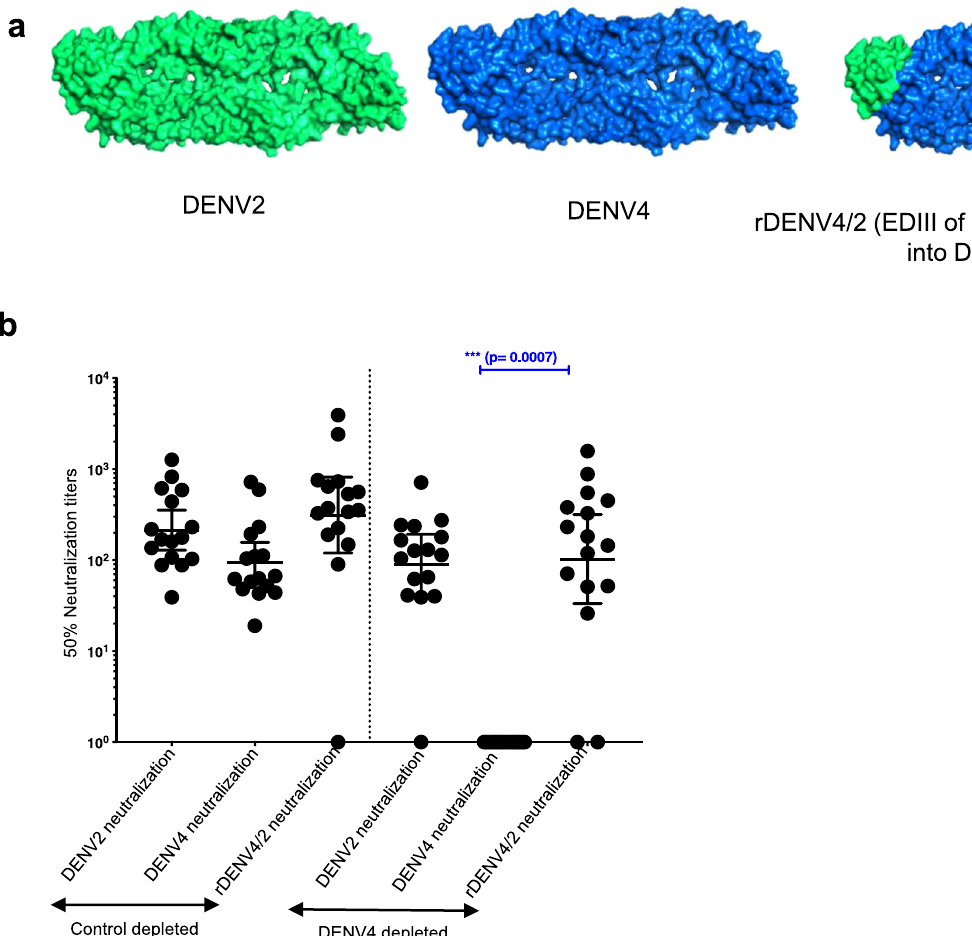
Fig. 7 TV003 induce varying levels of DENV2 serotype-speci fi c responses against known DENV2-neutralizing epitope domain. a DENV2 wt (green), DENV4 wt (blue) rDENV4/2 with the entire DENV2 EDIII domain transplanted into DENV4 (shown in green) are depicted. b Panel of 16 TV003 sera ( n = 16) with evidence of DENV2 TS responses were subjected to depletions against DENV4 to map the DENV2 TS nAb epitopes using the rDENV4/2 virus. Figure shows the Neut 50 titers for the BSA depleted and the DENV4 depleted serum samples against DENV2 wt, DENV4 wt and the rDENV4/2 viruses. Data were analyzed from a total number of 16 subjects indicated as dots from a single independent experiment and expressed as geometric mean titers ± 95% con fi dence intervals of the grouped samples. Nonparametric one-way Anova with Friedman Dunn ’ s multiple comparisons test ( b ) was used for the epitope mapping data to determine the loss or gain in neutralization to the recombinant chimeric viruses compared to the wild type parental backbone viruses. Each p -value was adjusted to account for multiple comparisons. (**** p < 0.0001; *** p < 0.001 ; **p < 0.01 ; *p < 0.05). The signi fi cant gain in neutralization of DENV2 TS nAbs against rDENV4/2 is indicated (*** p = 0.0007; CI: 95.0 – 535.7).